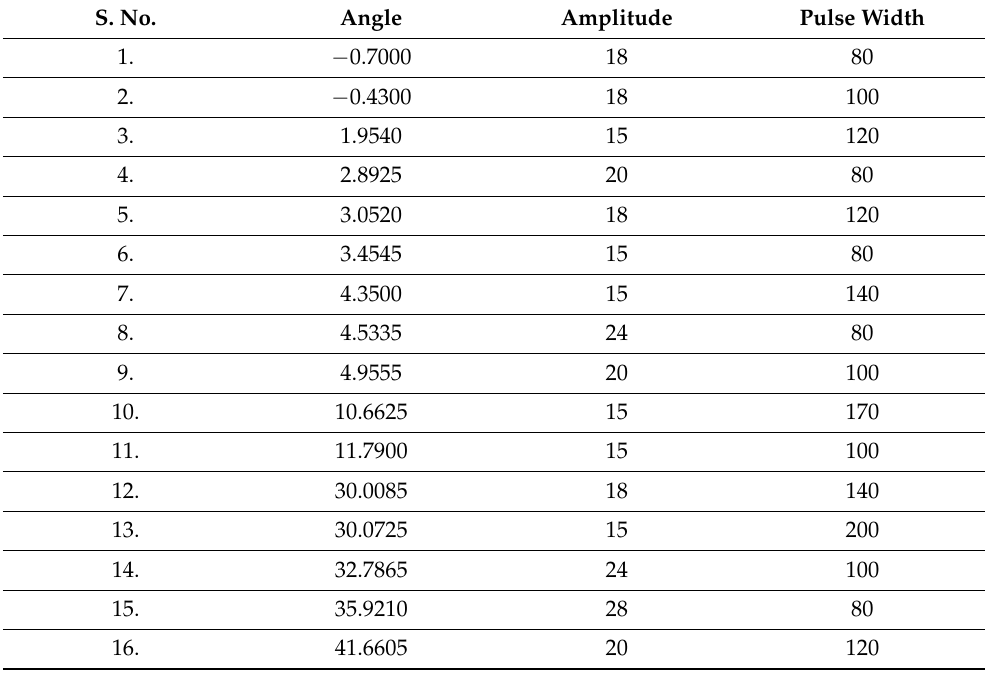
Table 1. Example of an extension table. The maximum encoder angle obtained for every increase in amplitude and/or pulse width of stimulation are recorded along with amplitude and pulse width values in a table called the calibration table. S. No. Angle Amplitude Pulse